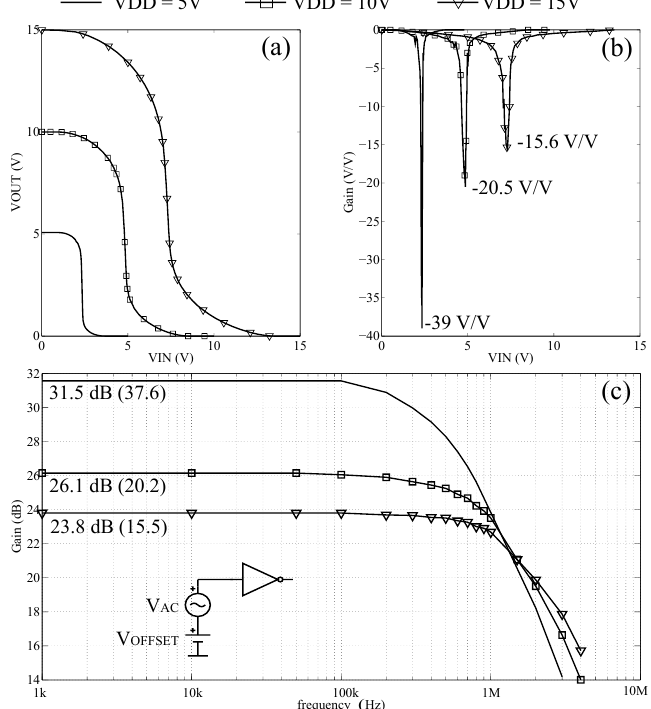
Figure 18. Characterization of a logic inverter in CD4007UBE as amplifier. ( a ) Voltage Transfer Characteristic curve of the inverter. ( b ) Static gain. ( c ) Transfer function of the